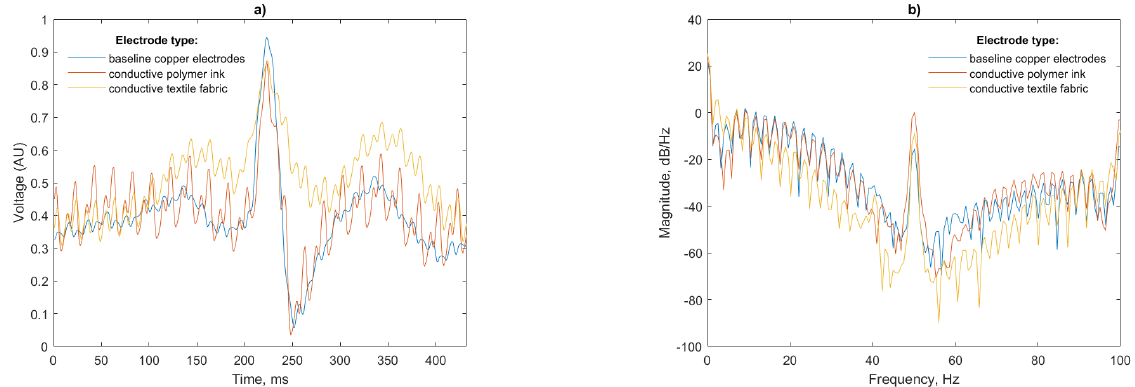
Figure 12. ( a ) Single beat waveform and ( b ) Power spectral density of a simulated ECG simulated from the test mannequin for each electrode configuration.